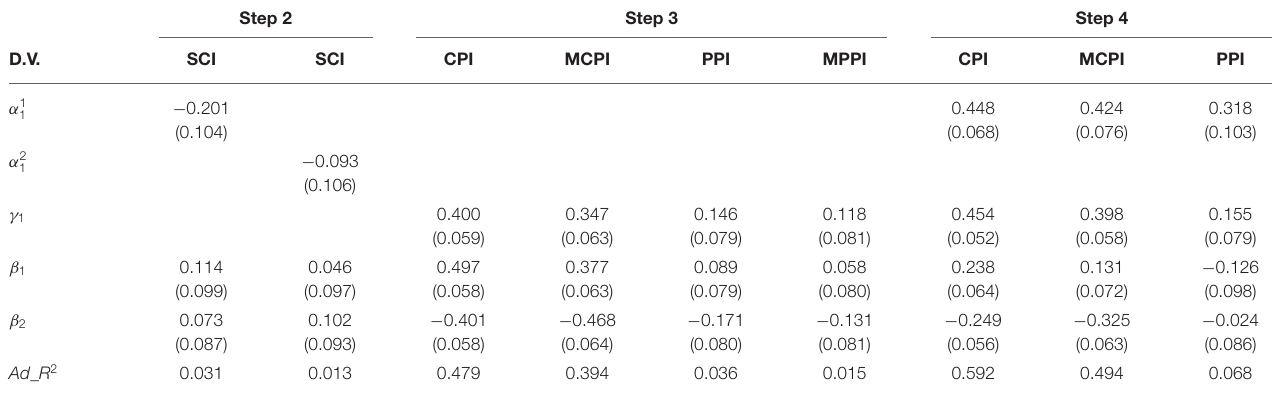
TABLE 6 | The test results for the financial market channel. Step 2 Step 3 Step